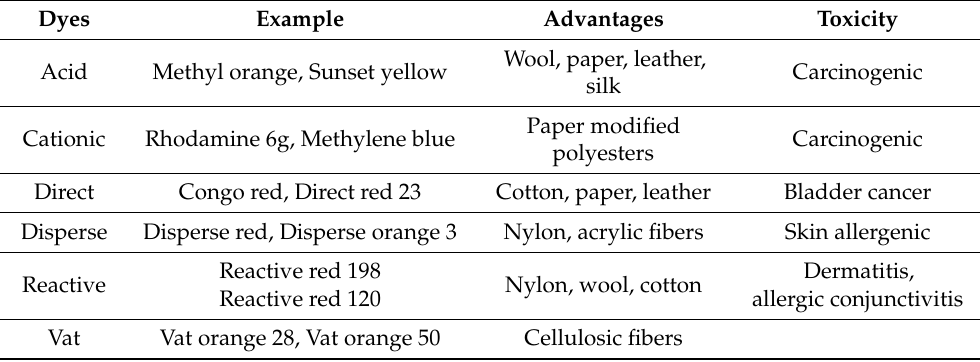
Table 2. Application and harmfulness of various dyes, reprinted with permission from